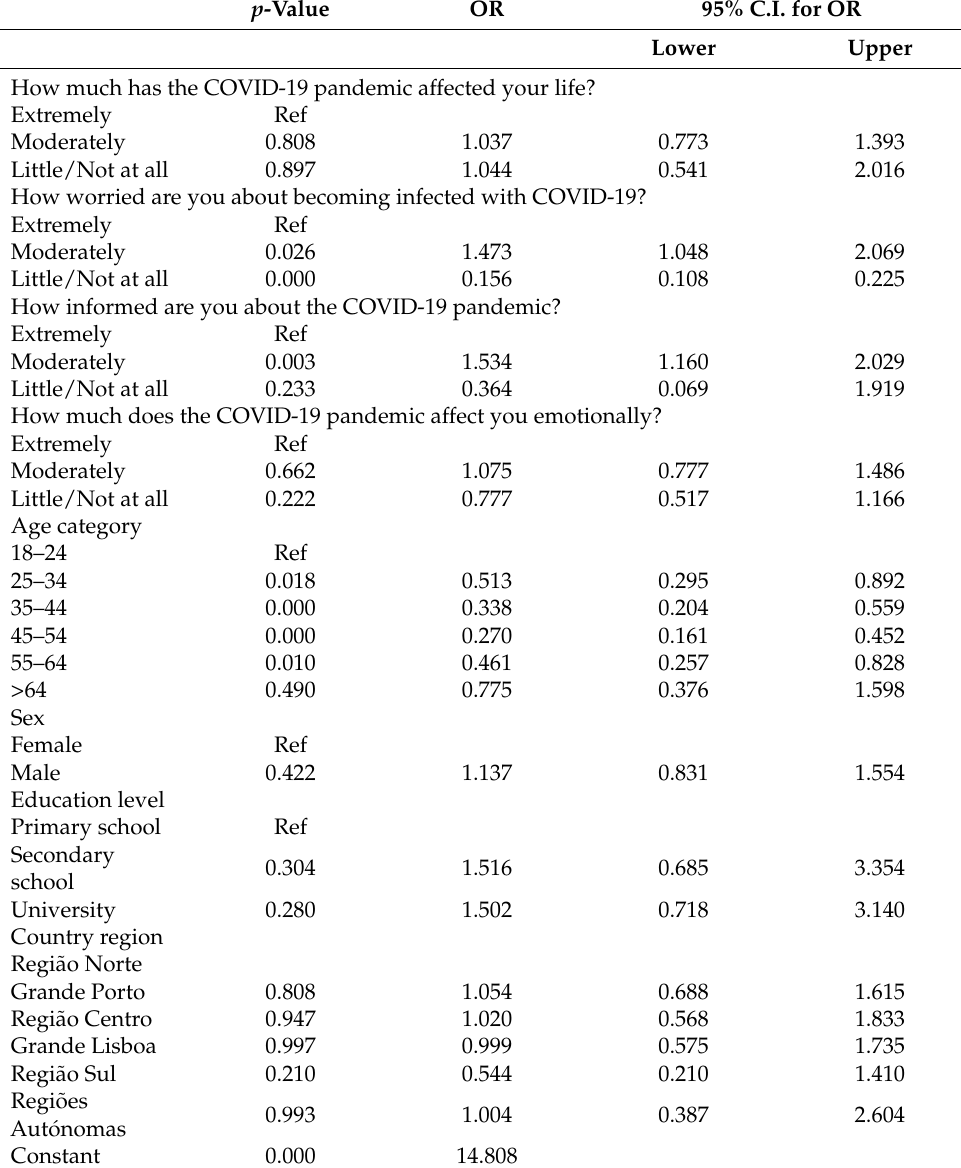
Table 2. Cognitive and Emotional Representations of COVID-19 and vaccine